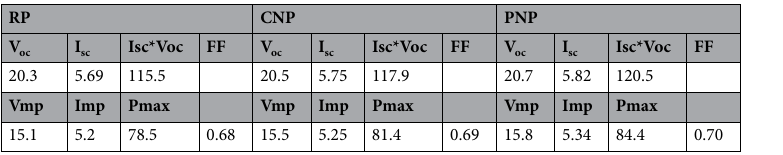
Table 7. The main parameters for the clean panel’s